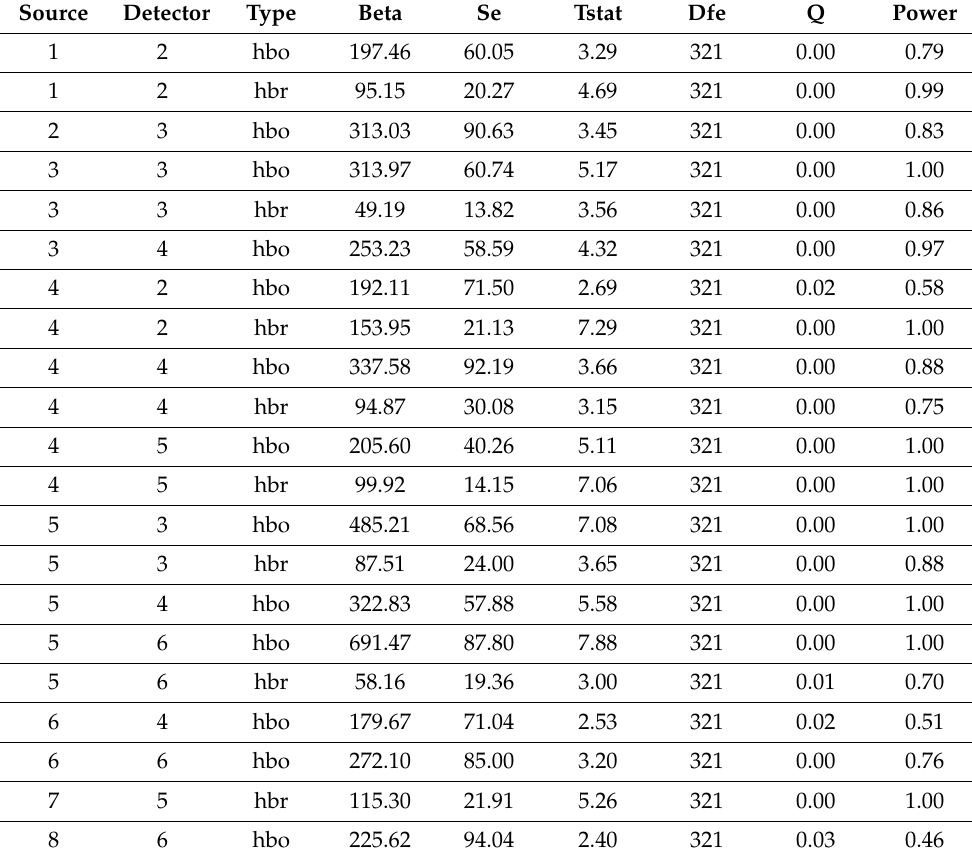
Table A3. t -test statistics for each channel (source–detector pair). Boat–Mountain Pose